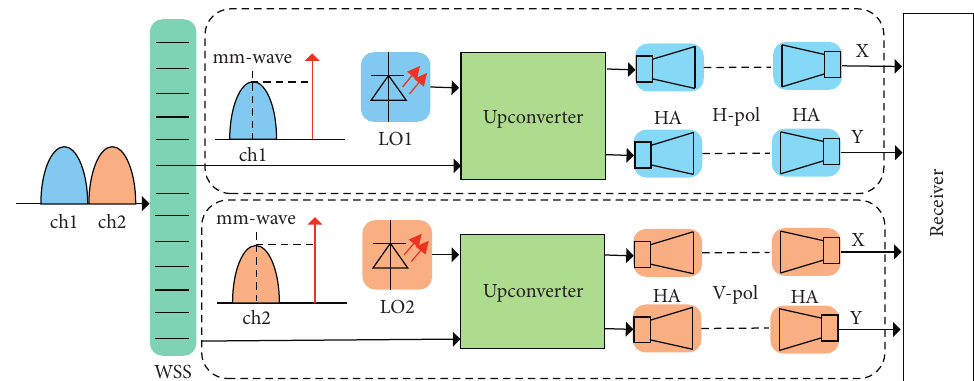
Figure 17: Antenna polarization multiplexing system structure diagram.